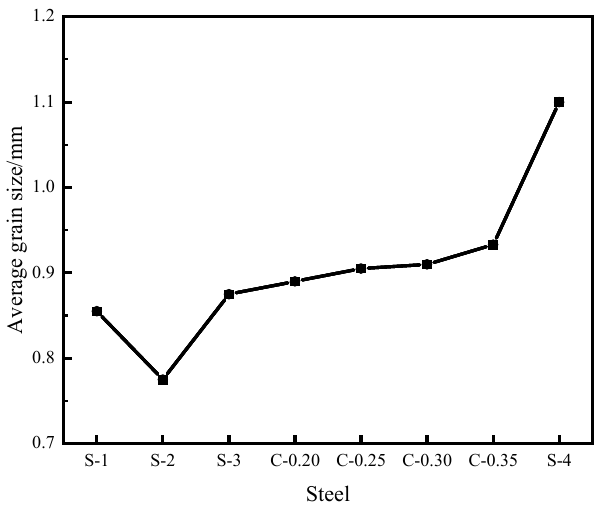
Figure 14. Average grain size of the equiaxed zone of different steels. Table 5. Chemical compositions (mass%) of simulated steel.